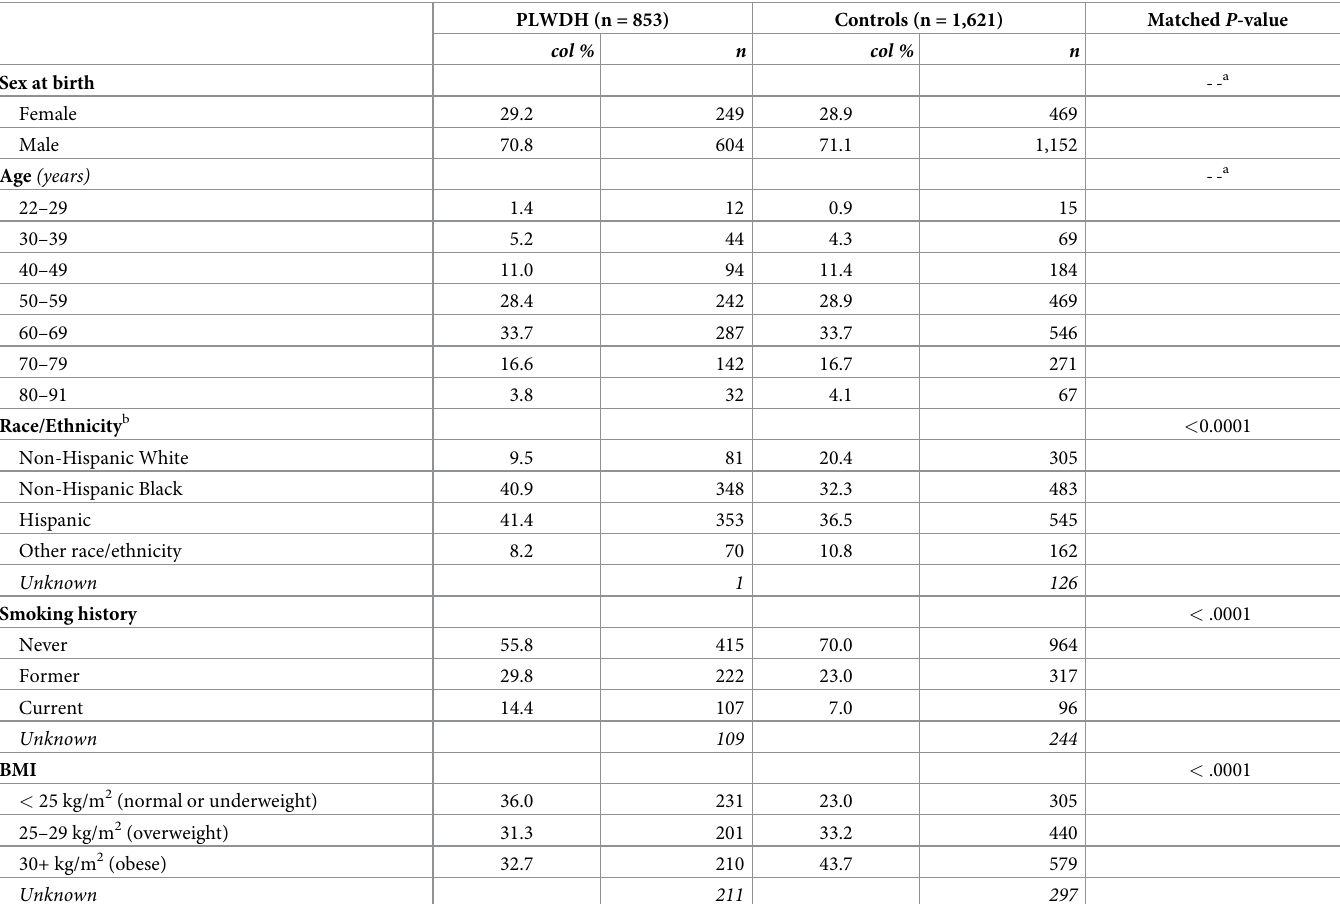
Table 1. Patient characteristics at admission among PLWDH and matched